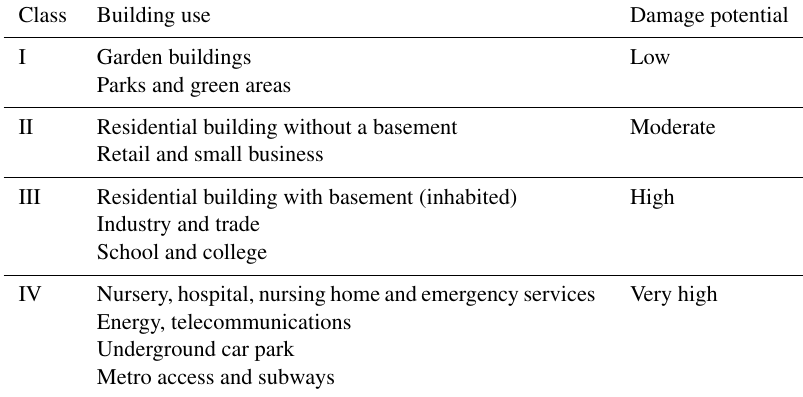
Table 1. Building use classification based on the guidelines of Krieger et al.